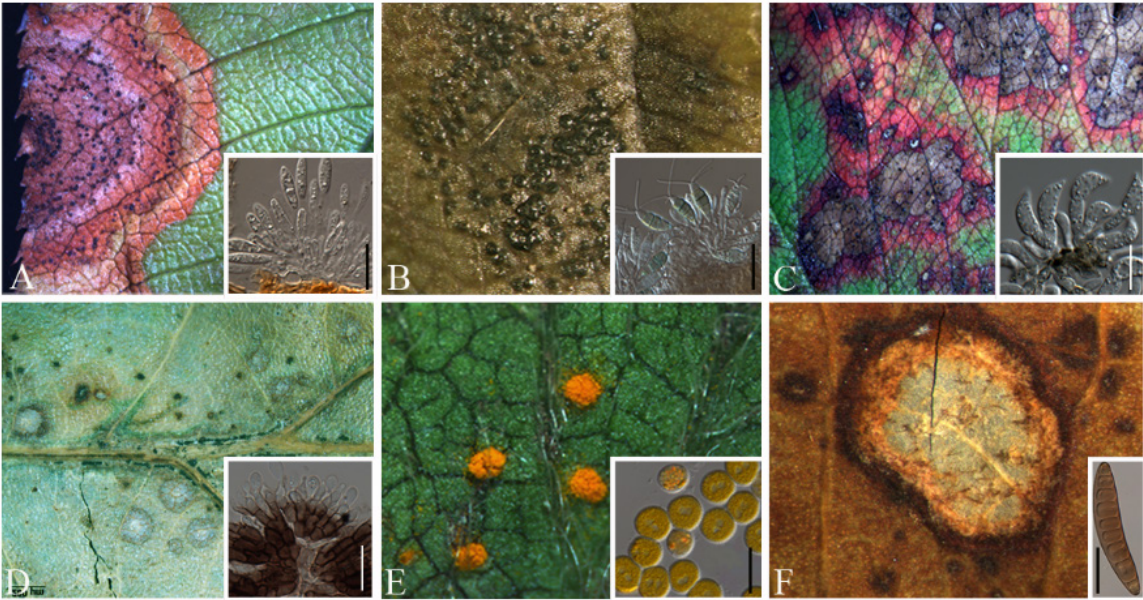
Figure 1 : Microscopic images of some foliar diseases and their causative agents. A) Leaf blight on Prunus serrulata (Japanese cherry ) caused by Botryosphaeria dothidea B) Leaf blight of Fragaria × annassa (cultivated strawberry) caused by Neopestalotiopsis sp. C) Leaf scorch of Fragaria × annassa caused by Diplocarpon fragariae D) Oak blight of Quercus macrocarpa (Bur Oak) caused by Tubakia iowensis E) Orange rust on Duchesnea indica (mock